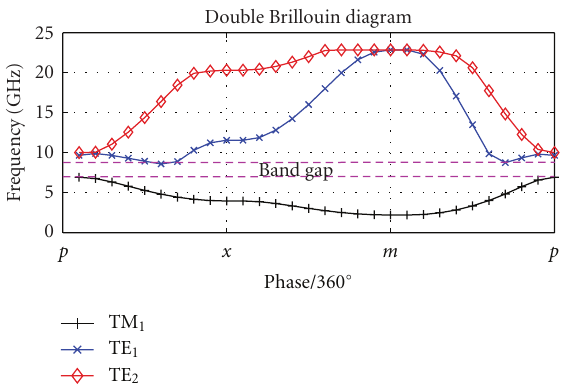
Figure 5: Brillouin diagram for double layer mushrooms.